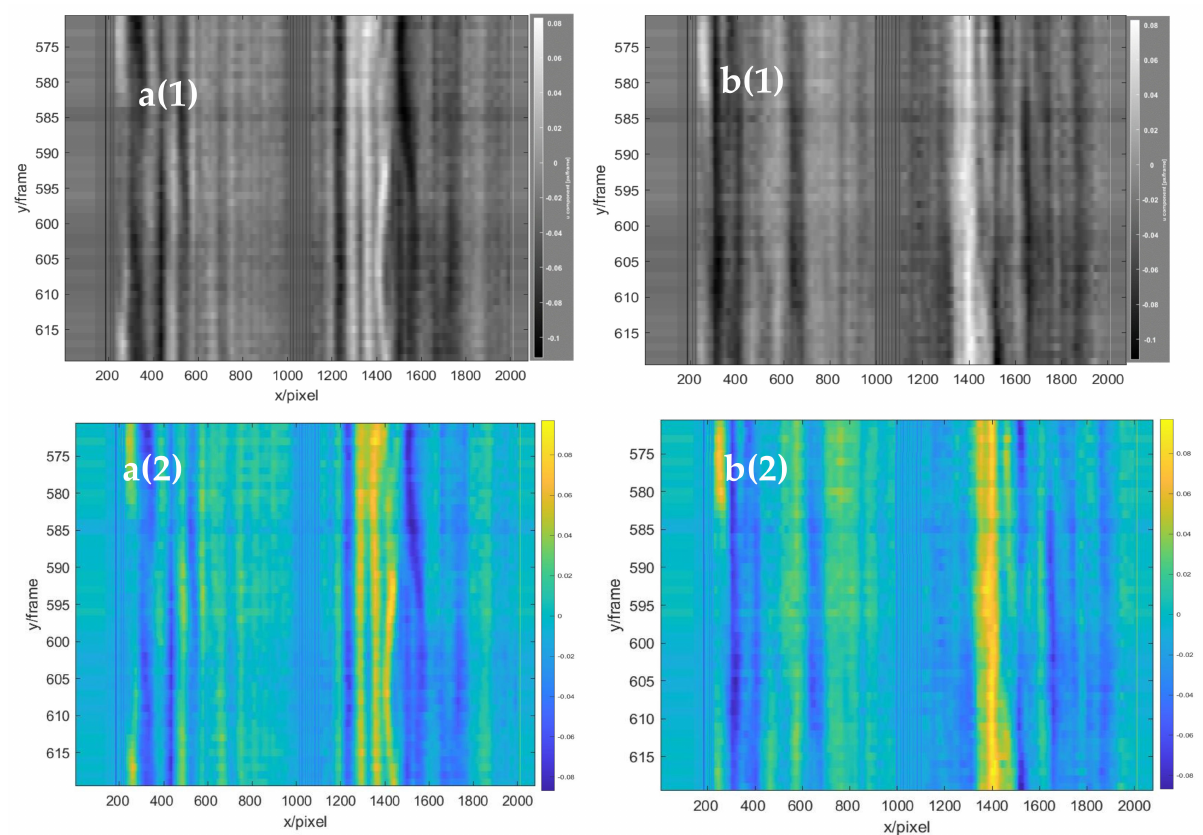
Figure 17. The stacked baseline analysis graphs in the horizontal direction of 50 frames. a ( 1 ) Baseline a (gray scale), and a ( 2 ) baseline a (RGB color). b ( 1 ) Baseline b (gray scale), and b ( 2 ) baseline b (RGB